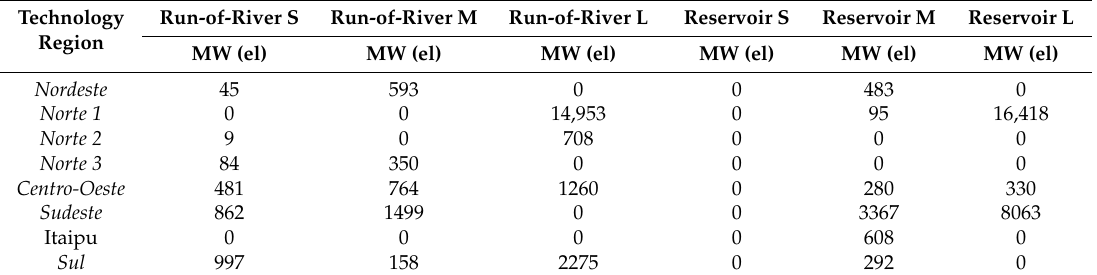
Table A6. Considered potential for additional hydropower installation based on [46,47]. Technology Region